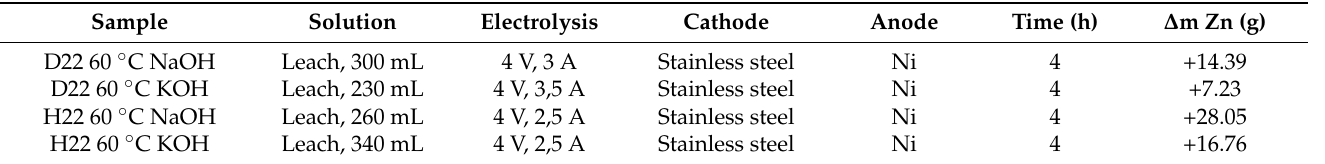
Table 19. The conditions and results of the electrolysis of the leaches obtained from leaching in NaOH and KOH solutions.